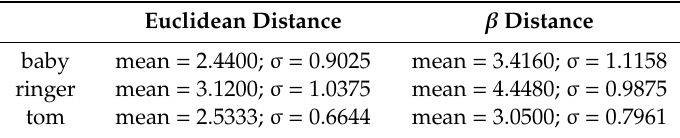
Table 1. Results of test in the form of mean scores and standard deviations for each sound obtained with the Euclidean distance and the β distance of Gaussian distribution D β for TFD i bases.